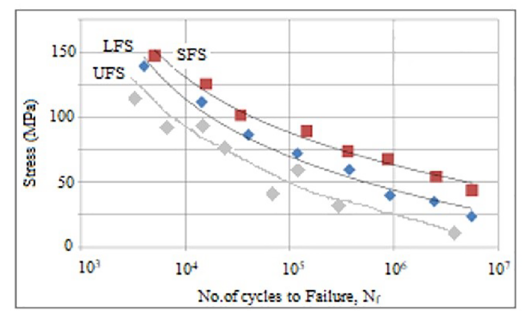
Figure 7. Fatigue stress and life of reinforced and unreinforced springs UFS and SFS exhibited the drop in spring rate and LFS exhibited fracture for all the taken into consideration masses.